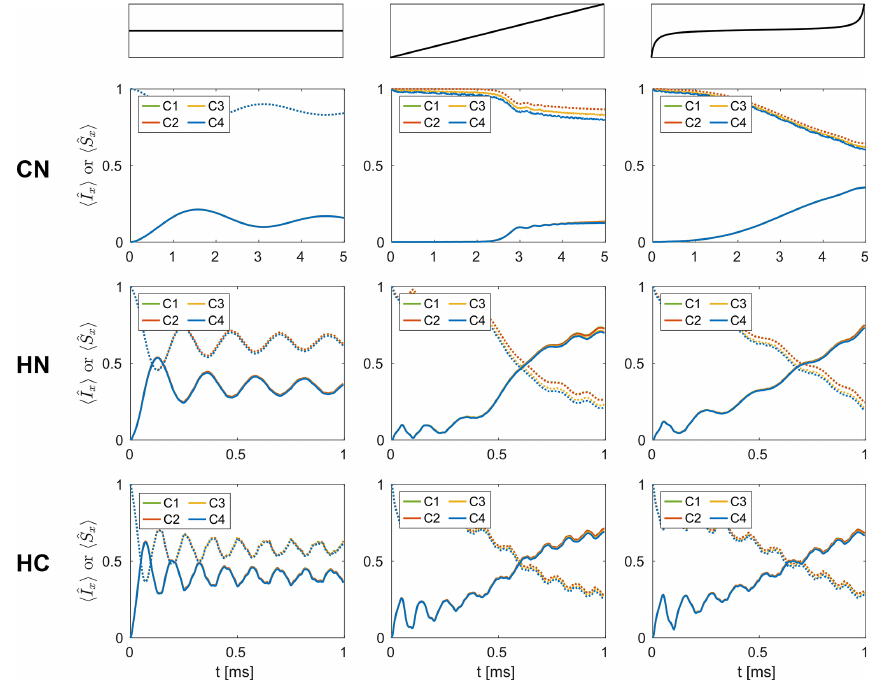
Figure 6. Simulated time evolution of the expectation value of the ˆ I x (dotted lines) and ˆ S x (solid lines) operators during CP zero quantum ˆ I ˆ S x → x polarization transfers in CN (top row), HN (middle row), and HC (bottom row) spin pairs for C1–C4 (see Table 1) in a 3.2mm probe at a proton resonance frequency of 600MHz, assuming a MAS frequency of 20kHz. Shown are magnetization transfers for constant rf amplitude (left-hand column), a linear rf amplitude modulation (middle column), and a tangential rf amplitude modulation on the source spin (right-hand column). The rf amplitude on the destination spin was kept constant (65kHz on N in CN, 50kHz on N in HN, and 70kHz on C in HC), and modulations of the rf amplitude on the source spin are shown in Fig. S4. Overall, no significant effects of the time-dependent amplitude and phase modulations due to radial contributions to the rf inhomogeneity are observed for the destination spin in any of the simulated